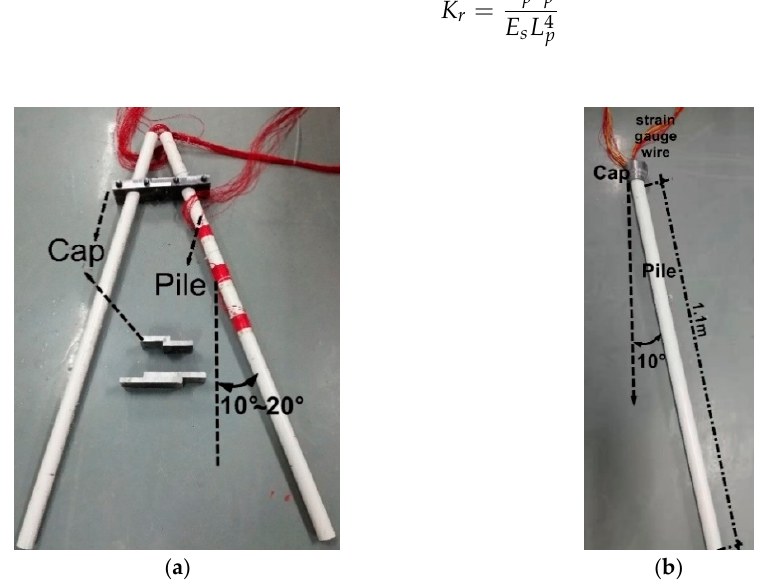
Figure 2. The diagram of the model pile. ( a ) The symmetrical batters and ( b ) the single batter pile.